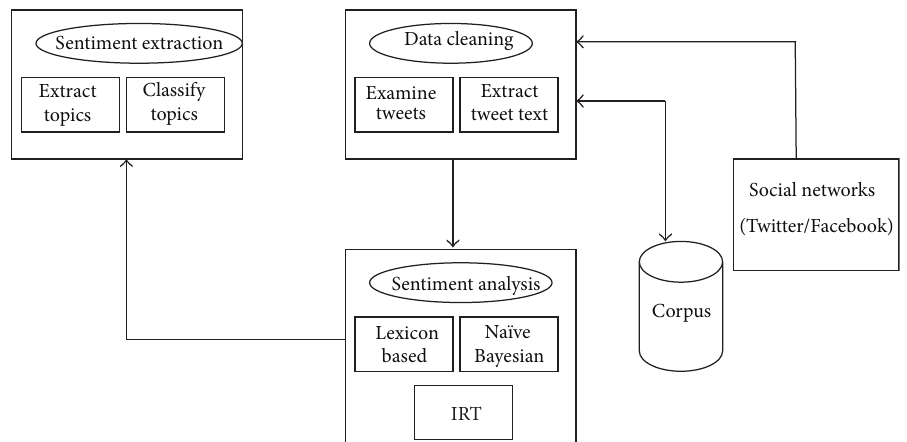
Figure 1: General architecture for topical